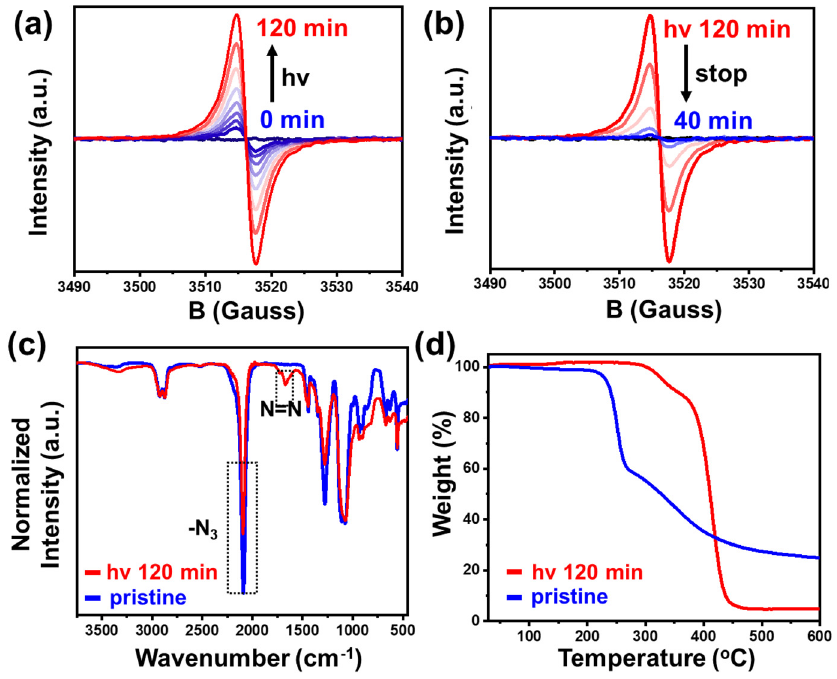
Figure 2. EPR spectrometry of GAP ( a ) with UV ‐ irradiation and ( b ) when the irradiation was stopped in a nitrogen atmosphere; ( c ) FT ‐ IR spectrometry and ( d ) TGA result of GAP samples before (blue) and after (red) UV ‐ irradiation (254 nm, 120 min).